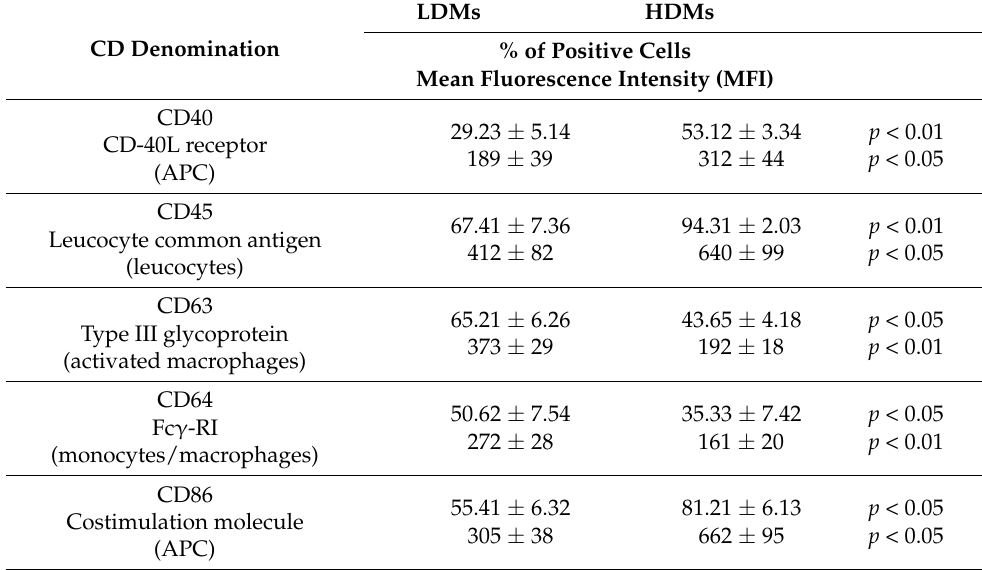
Table 3. Differential expression of surface molecules between LDMs and